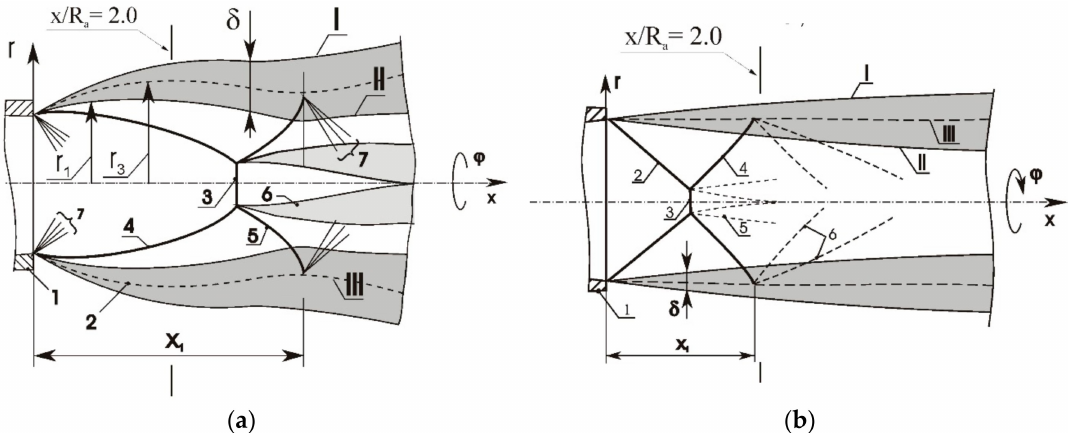
Figure 3. Diagram of the flow over the initial length of a supersonic jet at M a = 1 ( a ) and M a = 2 ( b ). Here, r 1 and r 3 are the radial distances referring to the location of the inner boundary and the centerline of the outer mixing layer; I and II are the outer and inner boundaries of the mixing layer; and III is the centerline of the mixing layer. ( a ) M a = 1, n p = 2.64, M j = 1.71; 1—nozzle; 2—mixing layer; 3—Mach disk; 4 and 5—barrel and reflected shocks; 6—inner shear layer formed behind the point of interaction of compression shocks 3, 4, and 5; 7—expansion fan; ( b ) M a = 2, n p = 0.64, M j = 1.71; 1—nozzle; 2—compression shock; 3—Mach disk; 4—reflected shock; 5—shear layer formed behind the point of interaction of compression shocks 2, 3, and 4; 6—expansion